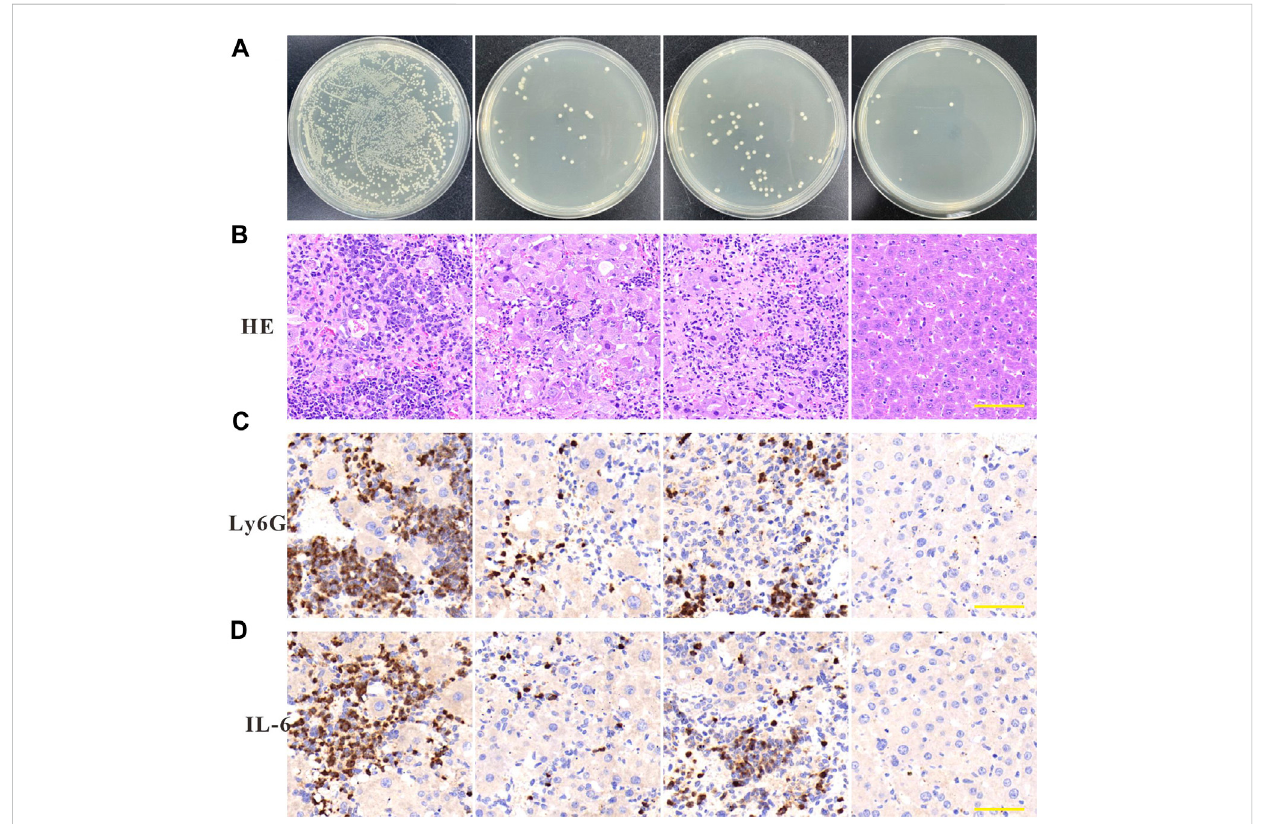
FIGURE 6 Anti-infection effects of Imi@ZIF-8 in vivo . After successful establishment of the mouse peritonitis model in A. baumannii , BALB/c mice were intraperitoneal injected with PBS, imipenem, ZIF-8, or Imi@ZIF-8 (10 mg imi/kg). (A) Bacterial counting of liver tissues after treated with the respective materials. Data are indicated as means ± SD ( n = 3). (B) Representative images of liver tissues after H&E staining at 7 days after intraperitoneal injection of differenttreatments. Scalebaris100 μ m. (C) ImmunohistochemistrystainingofLy6Ginlivertissuesat7 daysafterintraperitonealinjectedwithPBS, imipenem, ZIF-8, or Imi@ZIF-8, respectively. (D) Immunohistochemistry staining of IL-6 in liver tissues. Scale bar is 100 μ